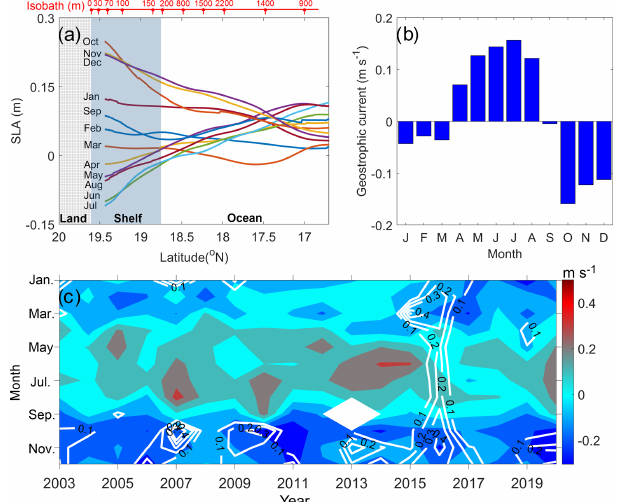
Figure 10. (a) Latitudinal distribution of climatological along-track SLA (track number: 114). (b) Geostrophic current retrieval from climatological along-track SLA. (c) Time series of geostrophic cur- rent (contours) and Chl a concentration (white contour curves). The shadings in (a) represent the ocean, continental shelf, and land ar- eas, respectively. The red bar with numbers in (a) indicates the water depth of the along-track SLA data. The values in (c) are the expo- nents of the Chl a concentration.